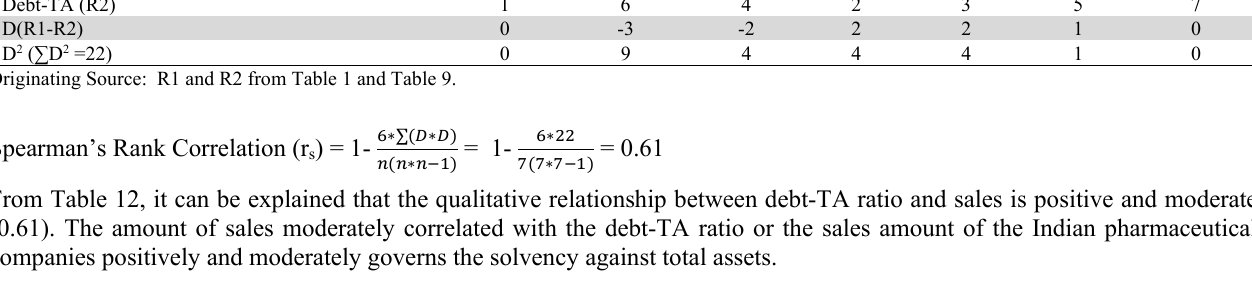
Qualitative relationship between Sales and TA relationship of Indian Pharmaceutical firms Ranks